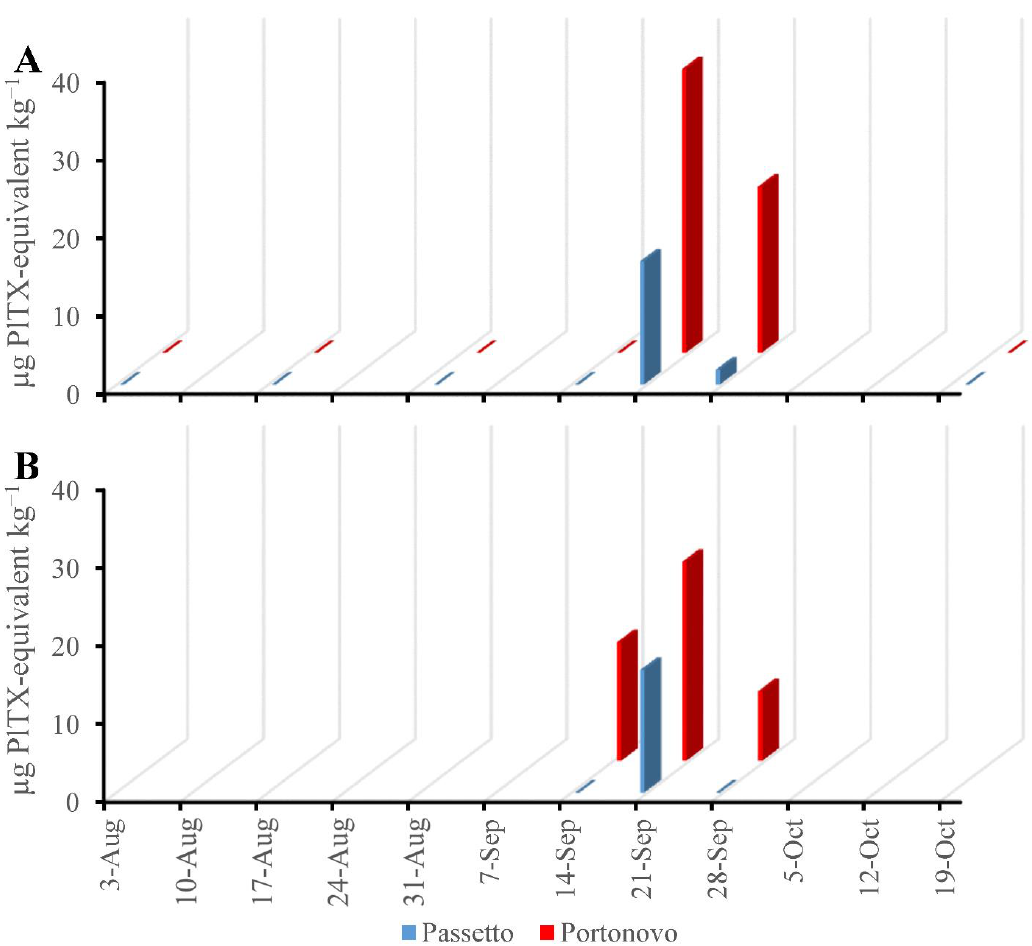
Figure 7. LC-MS/MS ( A ) and ( B ) UHPLC-HRMS 2 results showing the trends in the total content of palytoxin analogs (µg PlTX-equivalent kg − 1 of soft tissue) in mussels collected from natural banks at sampling stations (light-blue) Passetto and (red) Portonovo.